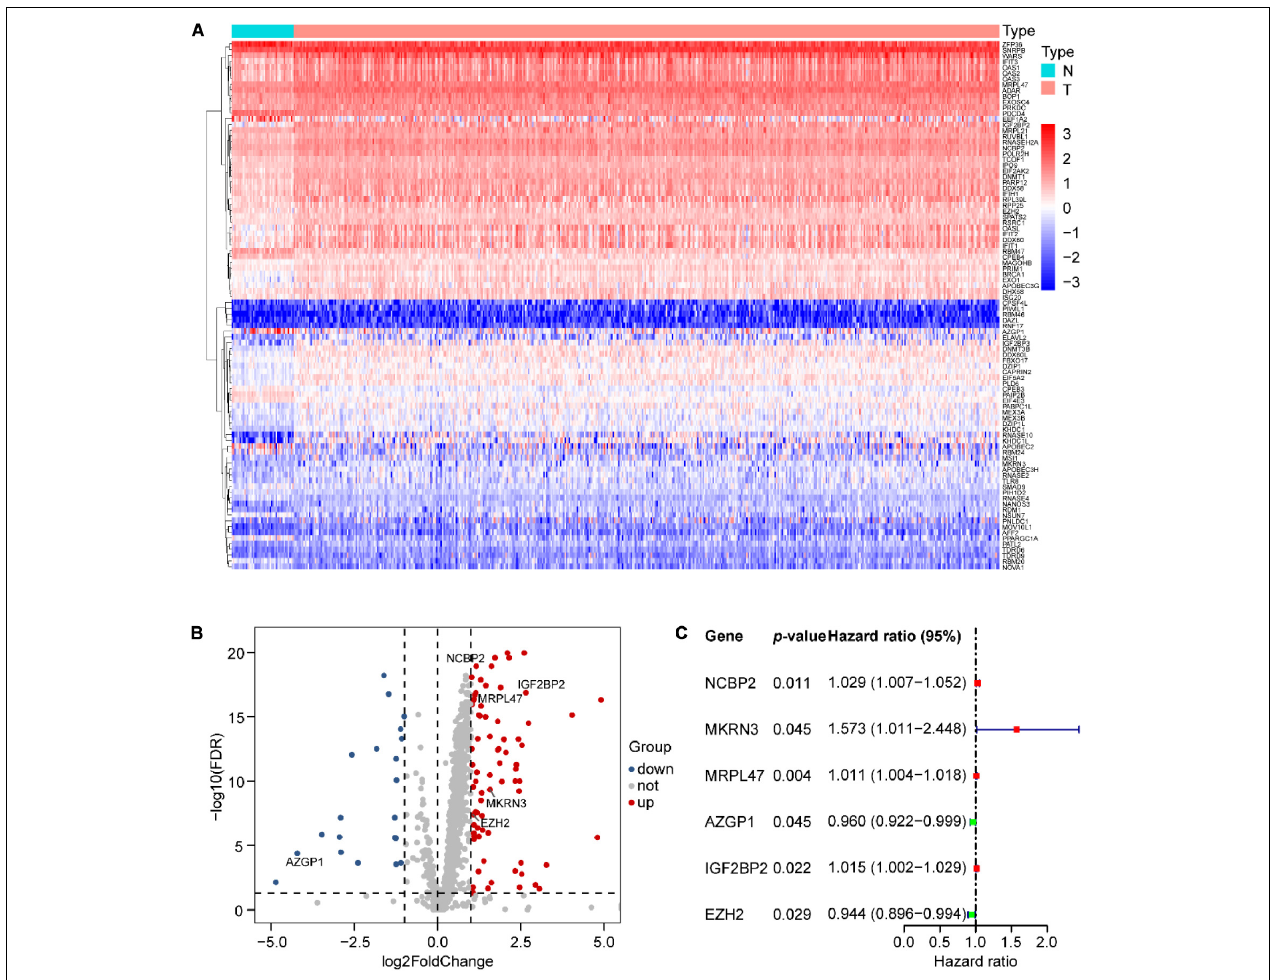
FIGURE 1 | Differential expression of RNA-binding proteins (RBPs) and six RBPs of prognostic risk models in SCCHN samples. (A) Ninety-two differential expression of RBPs (DERBPs) displayed by the heat map. (B) Seventy-four upregulated and eighteen downregulated DERBPs shown by the volcano plot (FDR < 0.05 and | logFC| > 1). (C) Characteristics of six risk DEARGs in the prognostic risk model exhibited by the forest plot.